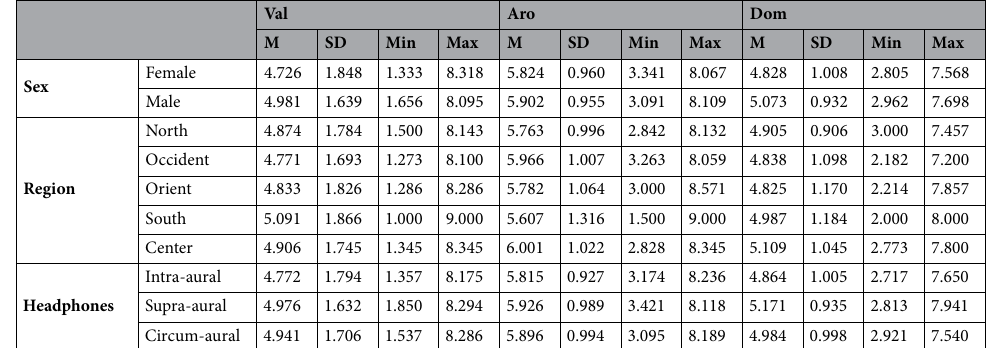
Table 2. Descriptive statistics for each dimension and category according to